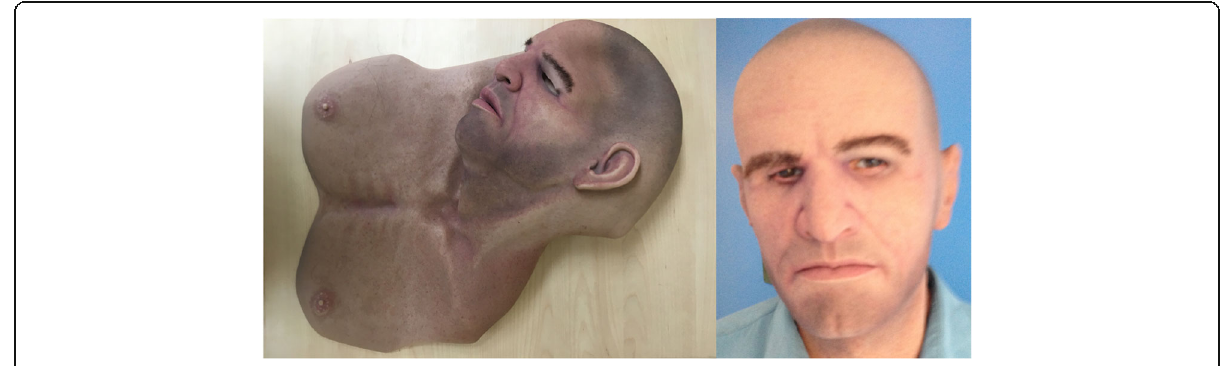
Fig. 1 Hyper-realistic dominant male mask ( right ) worn by author RJ ( left